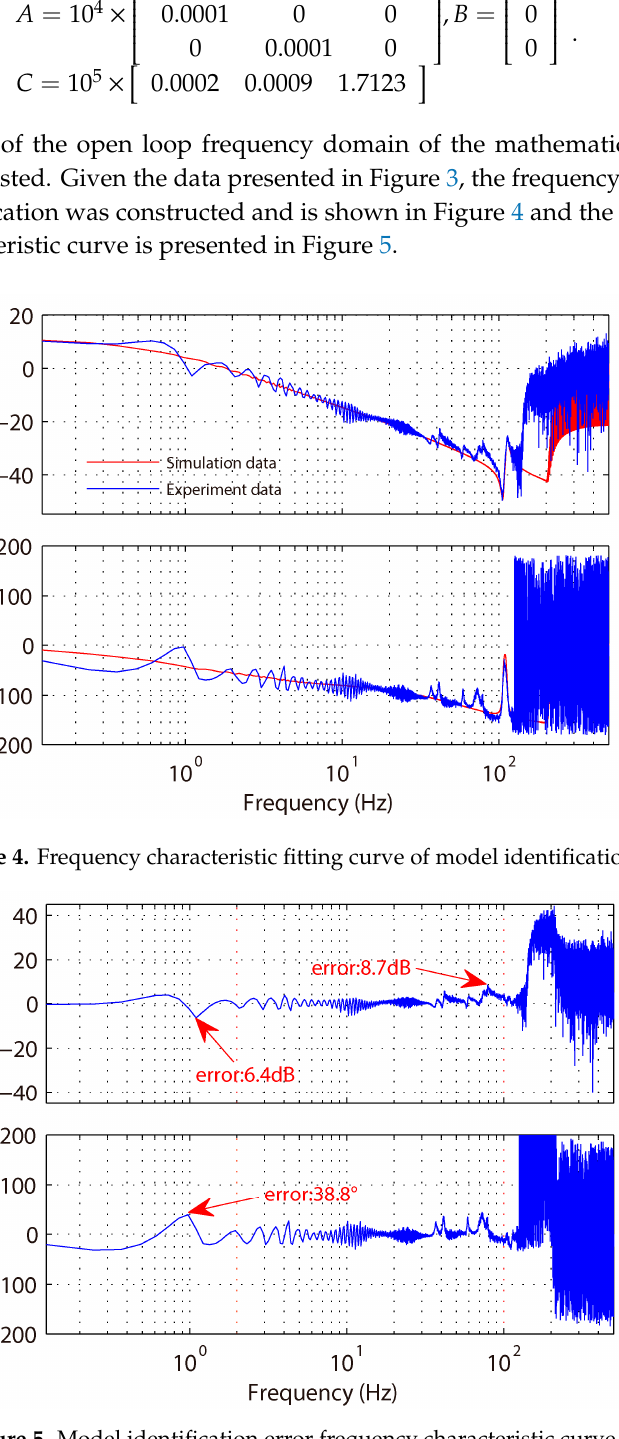
Figure 5. Model identification error frequency characteristic curve.